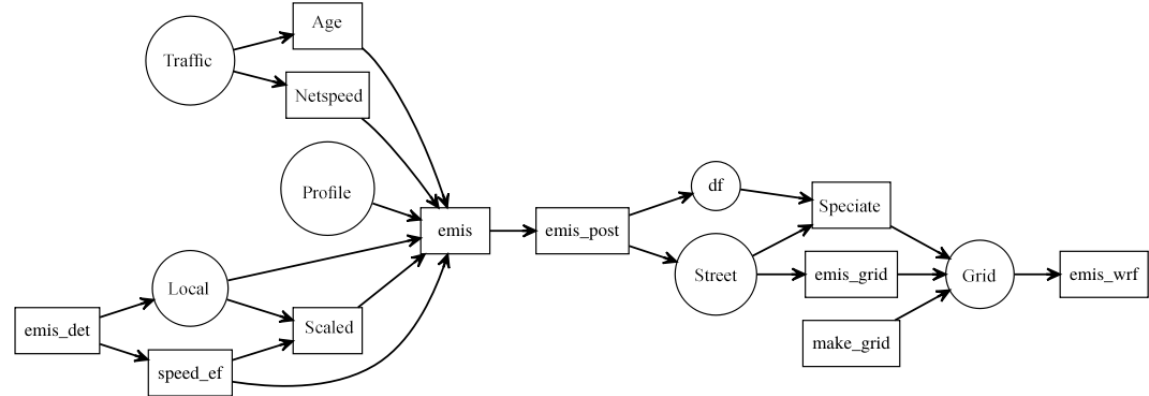
Figure 1. Representation of the VEIN model. Boxes and circles represent functions and data,